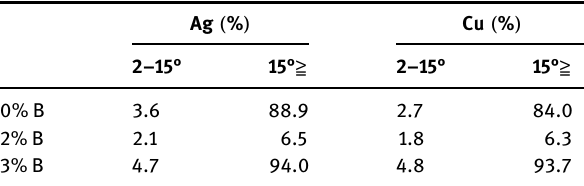
Table 5: Statistics of the misorientation angle of Ag ( s.s ) and Cu ( s.s ) in the brazing seam